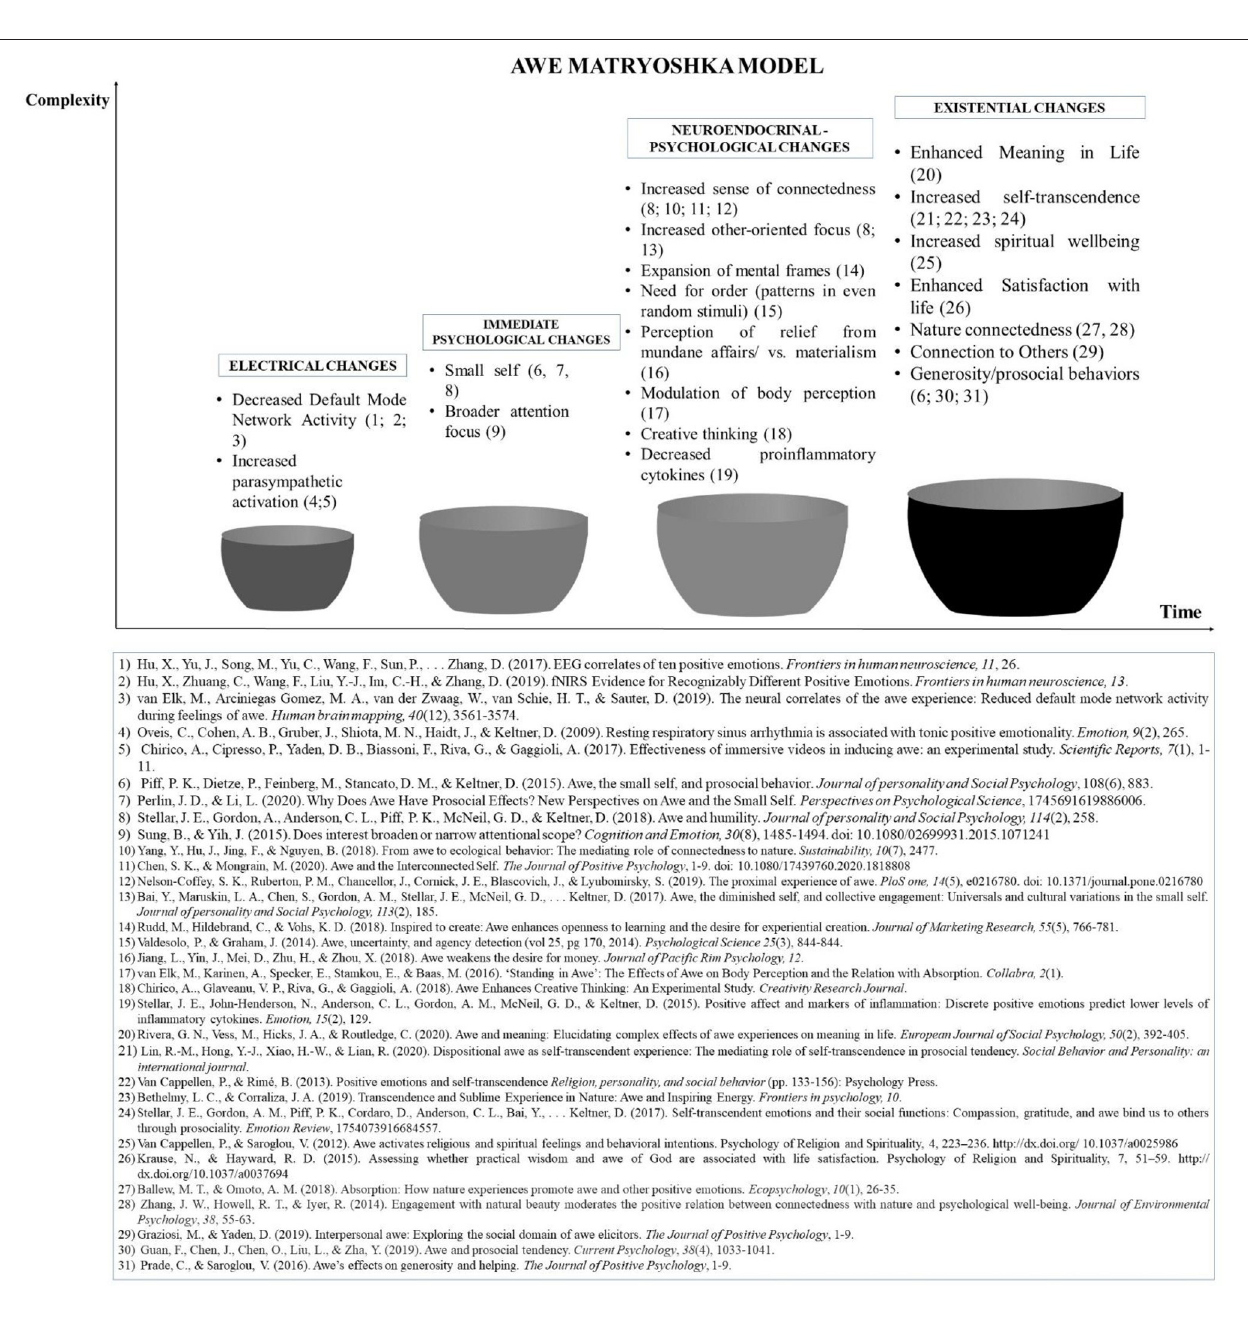
FIGURE 1 | The Matryoshka